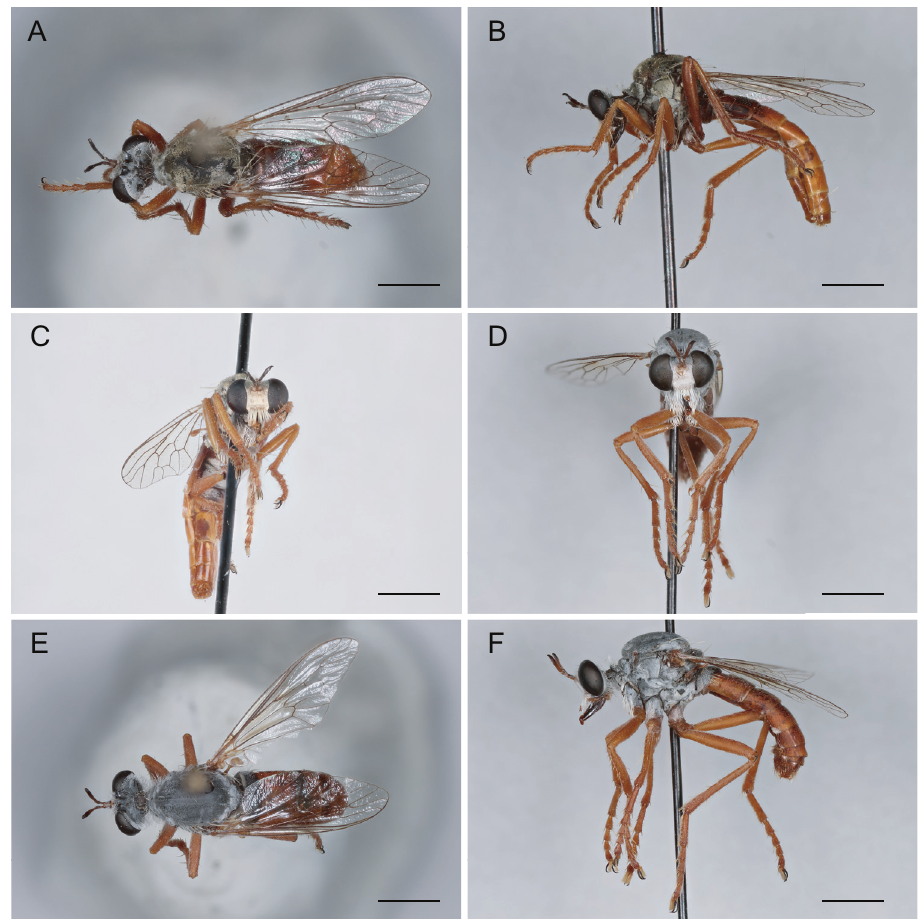
Figure 7. Saropogon albifrons Back, 1904 Female (USNMENT01819164): A dorsal view B lateral view C anterior view; Male (USNMENT01830072): D anterior view E dorsal view F lateral view. Scale bars: 2